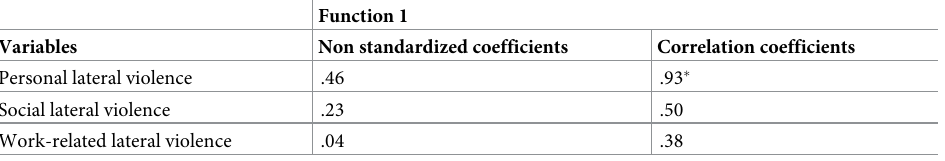
Table 5. Discriminant function analysis coefficients for independent variables and clusters obtained through the k-mean